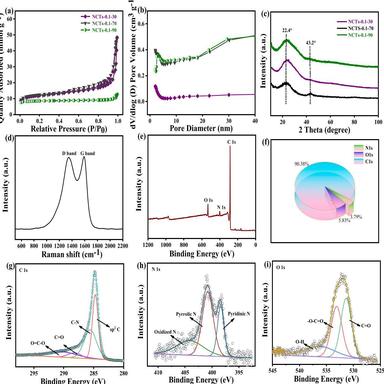
(a) N2 adsorption-desorption isotherm, (b) Pore size distribution (PSD) of NCTs-0.1–30/− 70/− 90, (c) XRD pattern of NCTs-0.1–30/70/90, (d) Raman spectra of NCTs-0.1–70, (e) XPS spectrum of NCTs-0.1–70, (f) Content of C, N, O elements, (g) C 1 s, (h) N 1 s, and (i) O 1 s XPS spectra of NCTs-0.1–70.